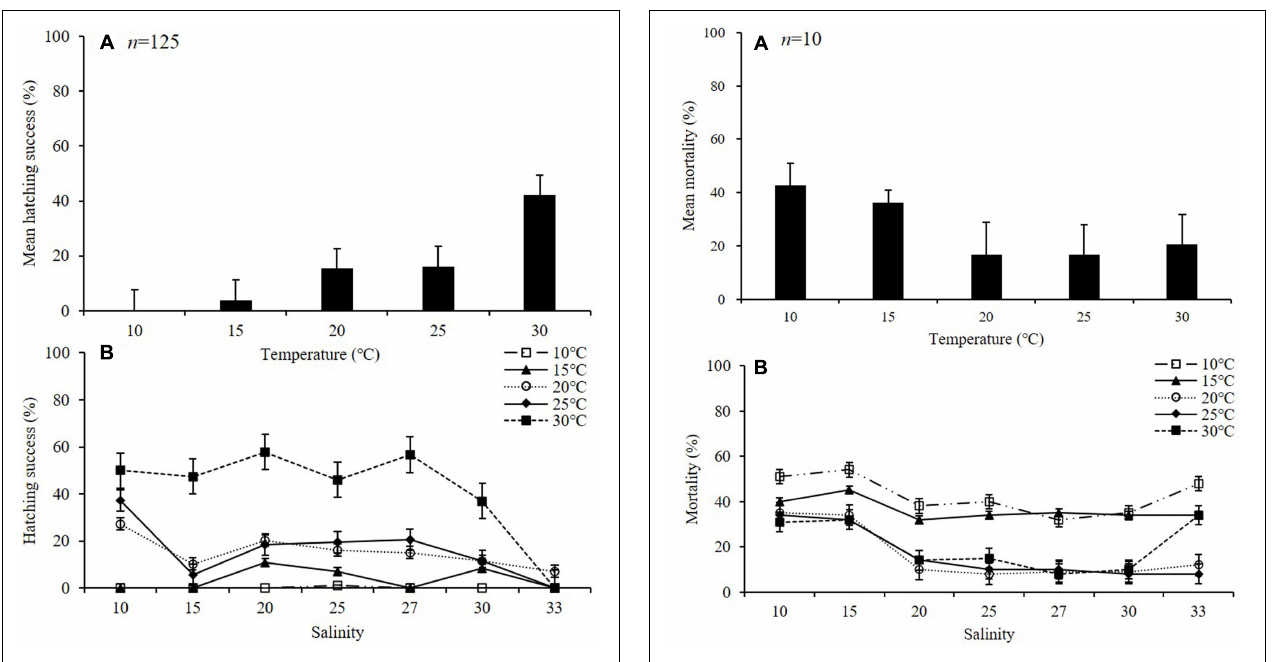
a low mortality rate in the range of salinity of 20–33